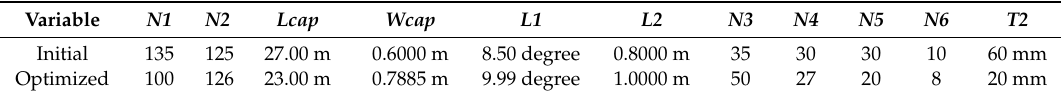
Table 2. Description of design variables.